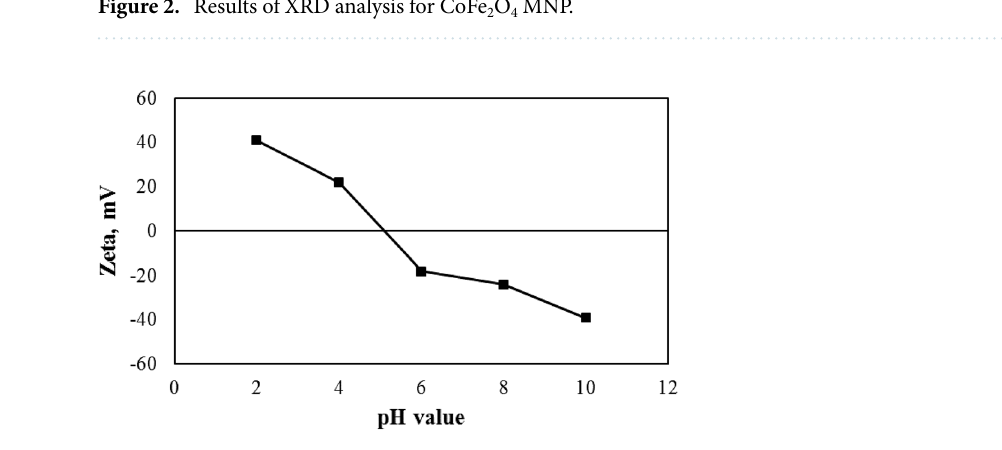
Figure 3. Results of Zeta potential measurement versus pH values for CoFe 2 O 4 MNP in water.